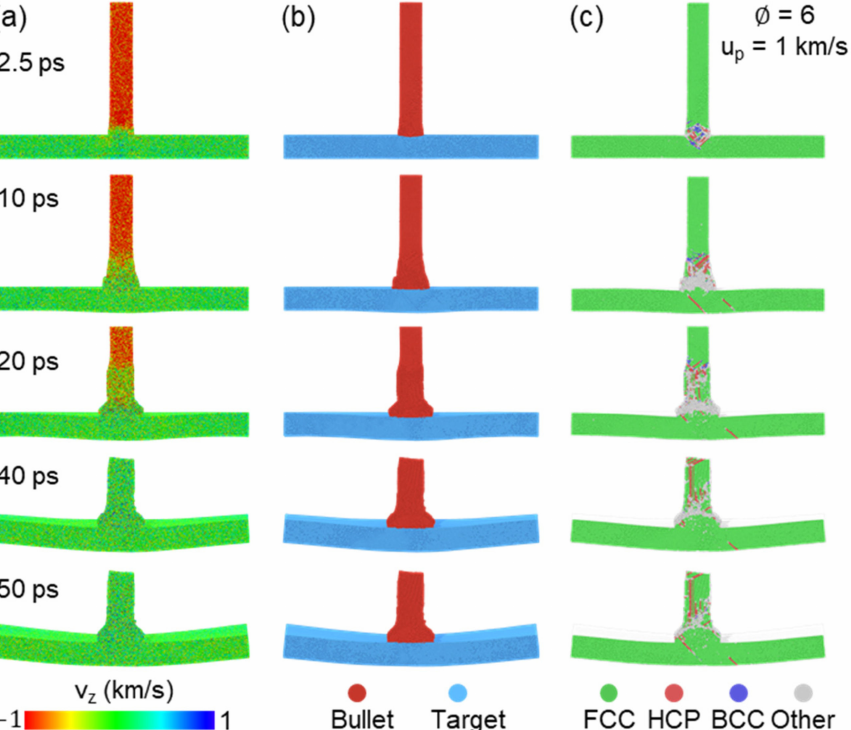
Figure 2. Unpenetrated atomic configurations at several times for the case of ∅ = 6 and u p = 1 km/s. The atoms are colored by ( a ) velocity along impact direction, ( b ) matter distribution and ( c ) mi- crostructure recognized by adaptive-CNA